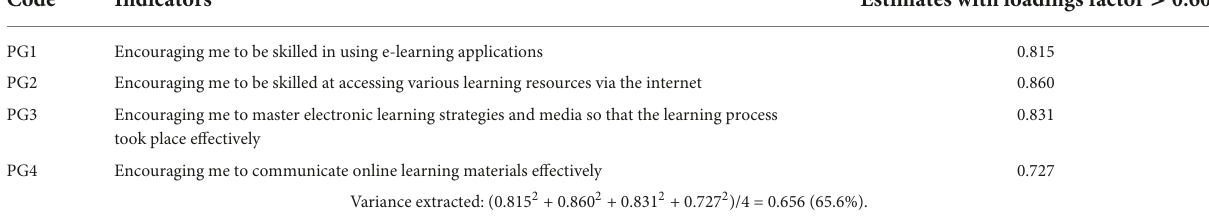
TABLE 8 The loading factor from the indicator to the teachers’ behavior variable during the COVID-19 pandemic. Code